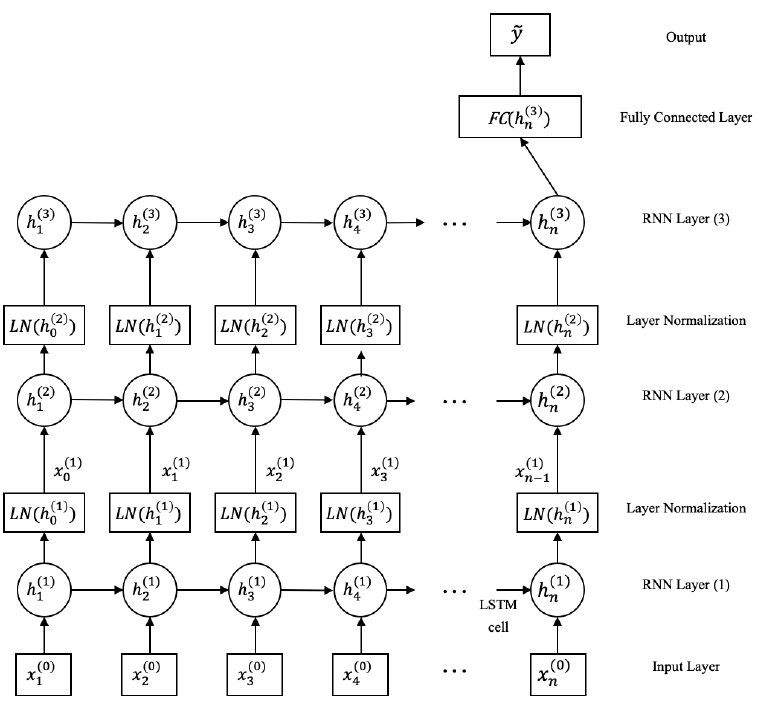
Figure 7. The architecture of Deep-RNN.